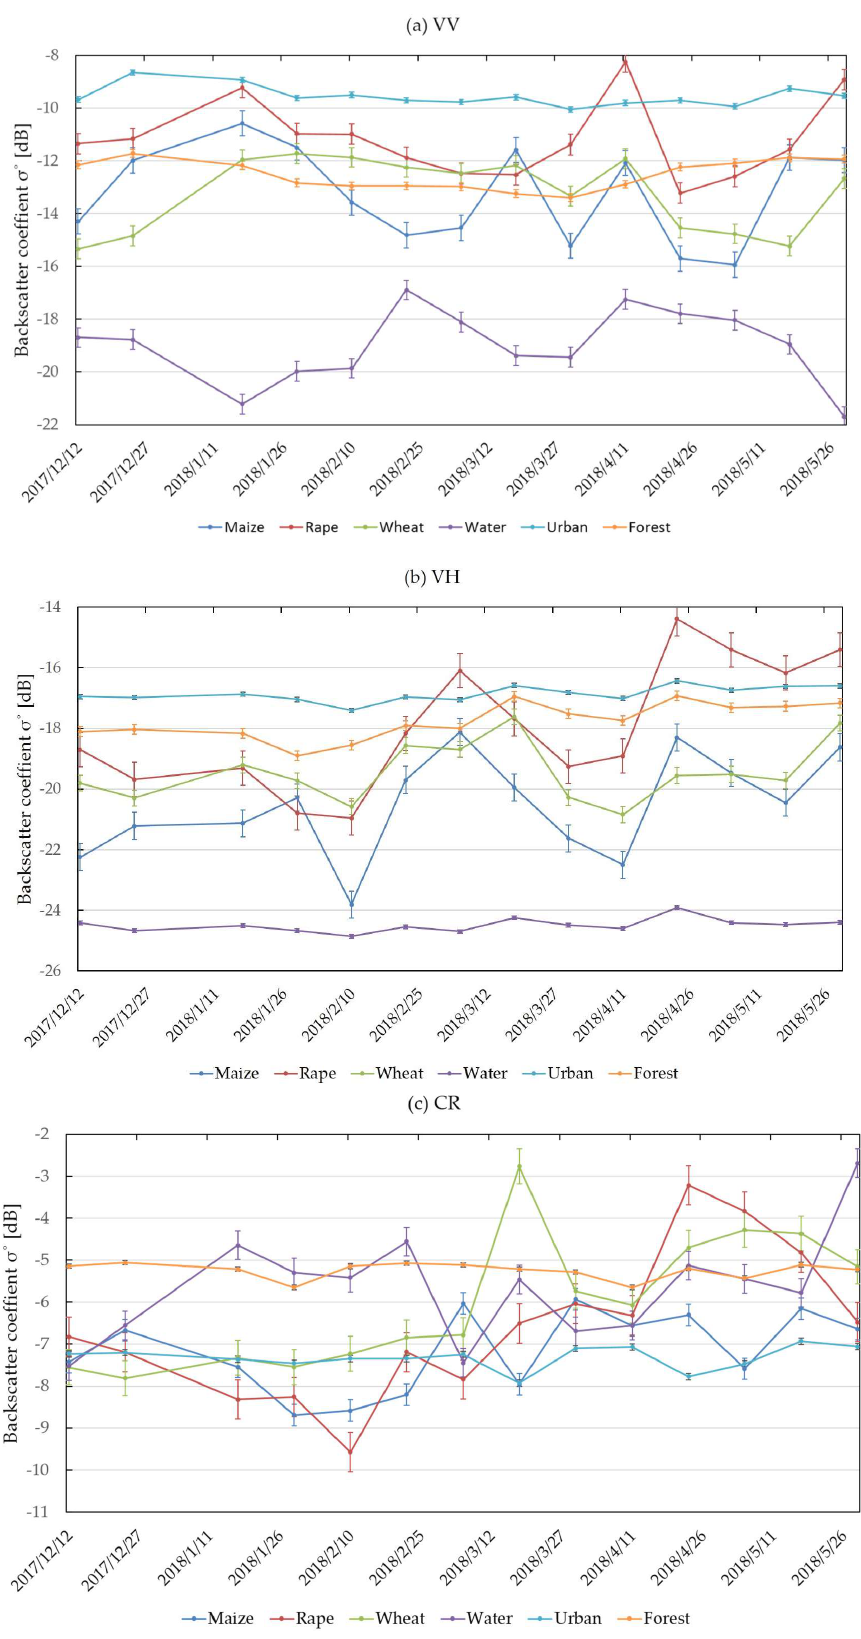
Figure 2. Six land cover features of Sentinel-1 backscatter coefficients of a time series: ( a ) (vertical-vertical) VV, ( b ) (vertical-horizontal) VH and ( c ) Cross Ratio (CR).